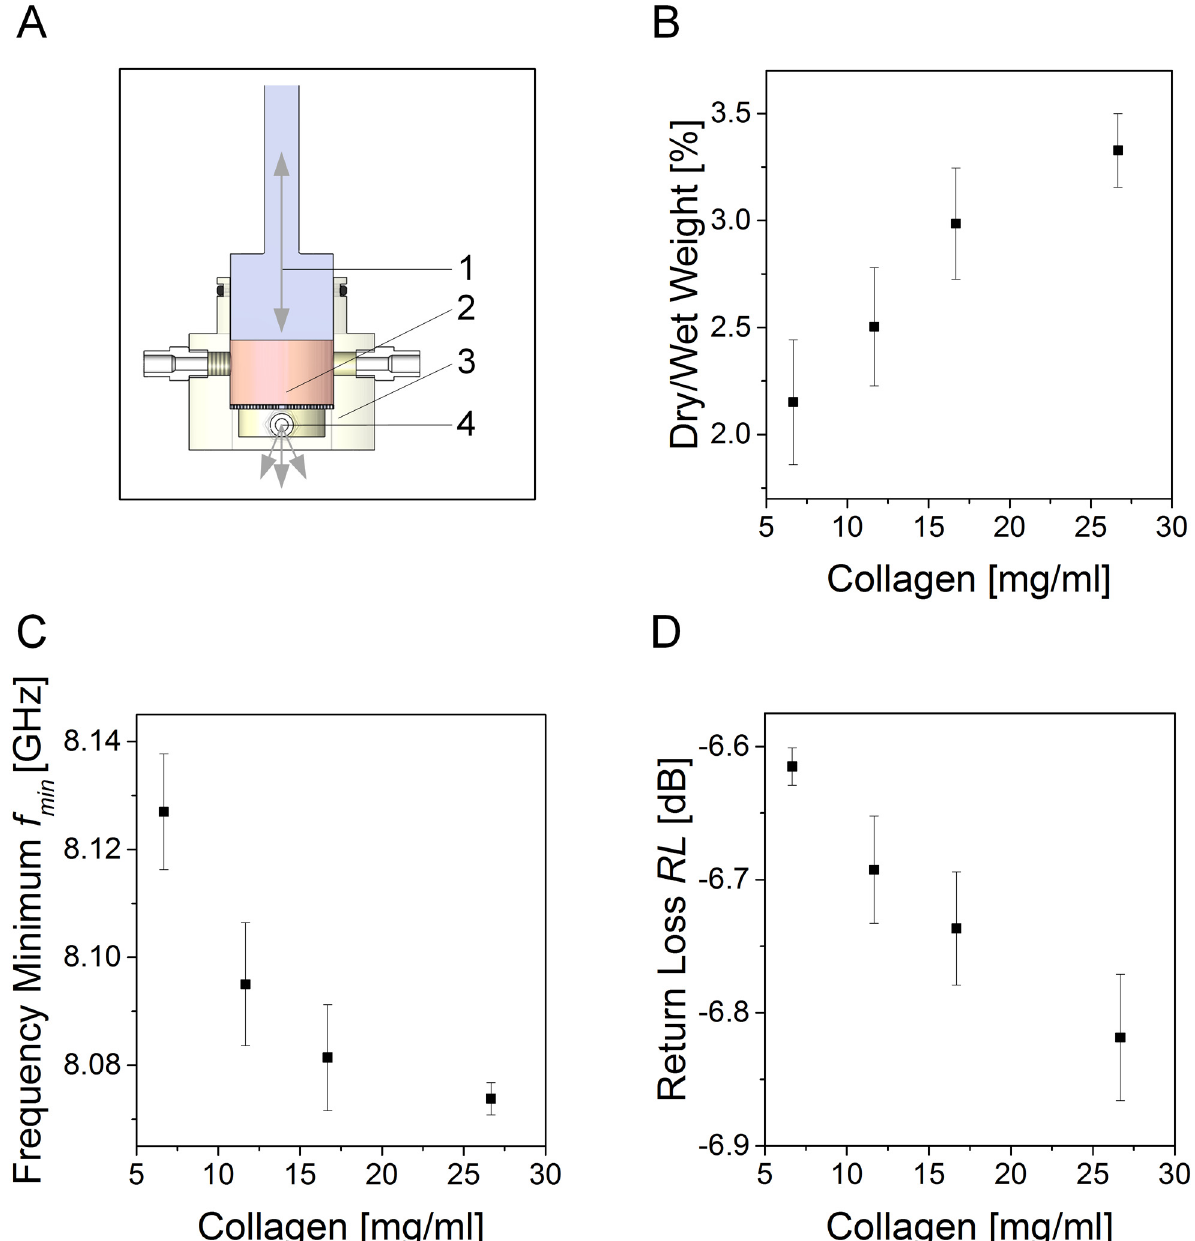
Fig 3. Measurement of cell-free dermal equivalents at different collagen concentrations. (A) A plastic compression system allowed generating dermal equivalents exhibiting collagen concentrations ranging from c = 6.67 mg/ml to c = 26.67 mg/ml. During processing, hydrogels were compressed to a defined volume of V = 3.6 cm 2 employing a linear motion engine. The squeezer (1) compressed the hydrogel (2) in the bioreactor (3). Pried water was aspirated via the port near the bottom of the chamber (4). (B) Comparison of dry to wet weight showed an increase in weight with a higher collagen concentration, whereas (C) f min at the detected minimum declined with a higher collagen concentration, and (D) RL decreased at higher collagen concentration. Plots show mean values, error bars depict standard deviation. Each group comprised 3 individual samples that were measured in triplicate.